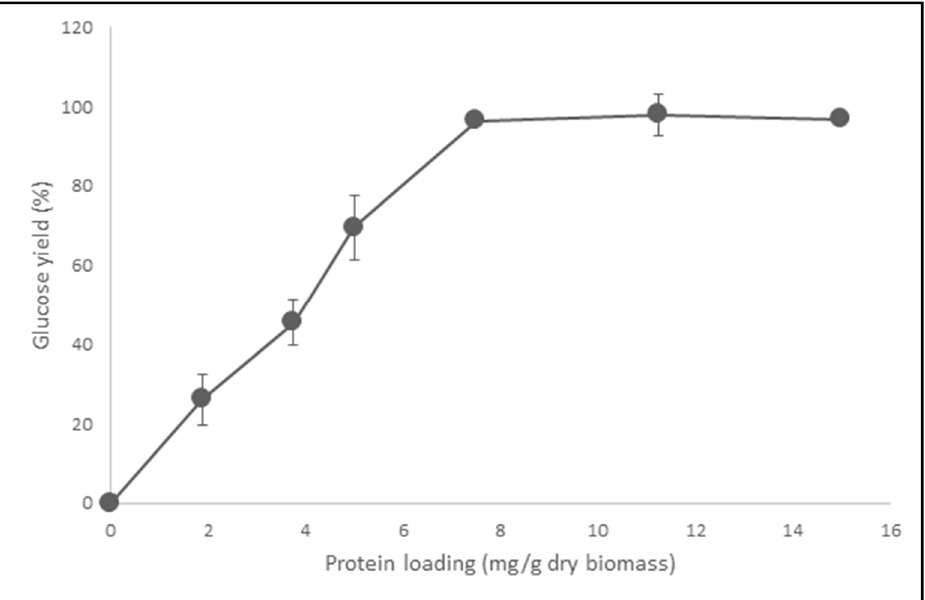
Figure 4. Glucose yield obtained from the hydrolysis of 2% ( w / v , DM) paper sludge for 48 h at 50 °C using varying protein loadings (1.875 to 15 mg/g biomass) of the formulated cellulase cocktail with BGL at 10% protein loading. All experiments were performed in quadruplicate, and the mean values and error bars (±SD) were calculated. The statistical analysis showed that the differences were statistically significant (one-way ANOVA, p < 0.05).